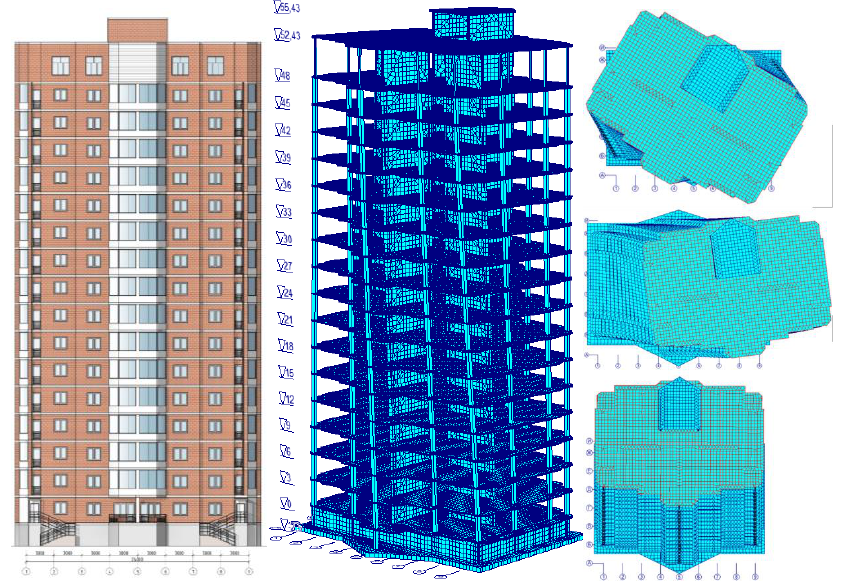
Fig. 1. Analysed multi-storey residential building on the basis of standard design series "KUB 2.5" and its three principal modes of natural oscillations (top